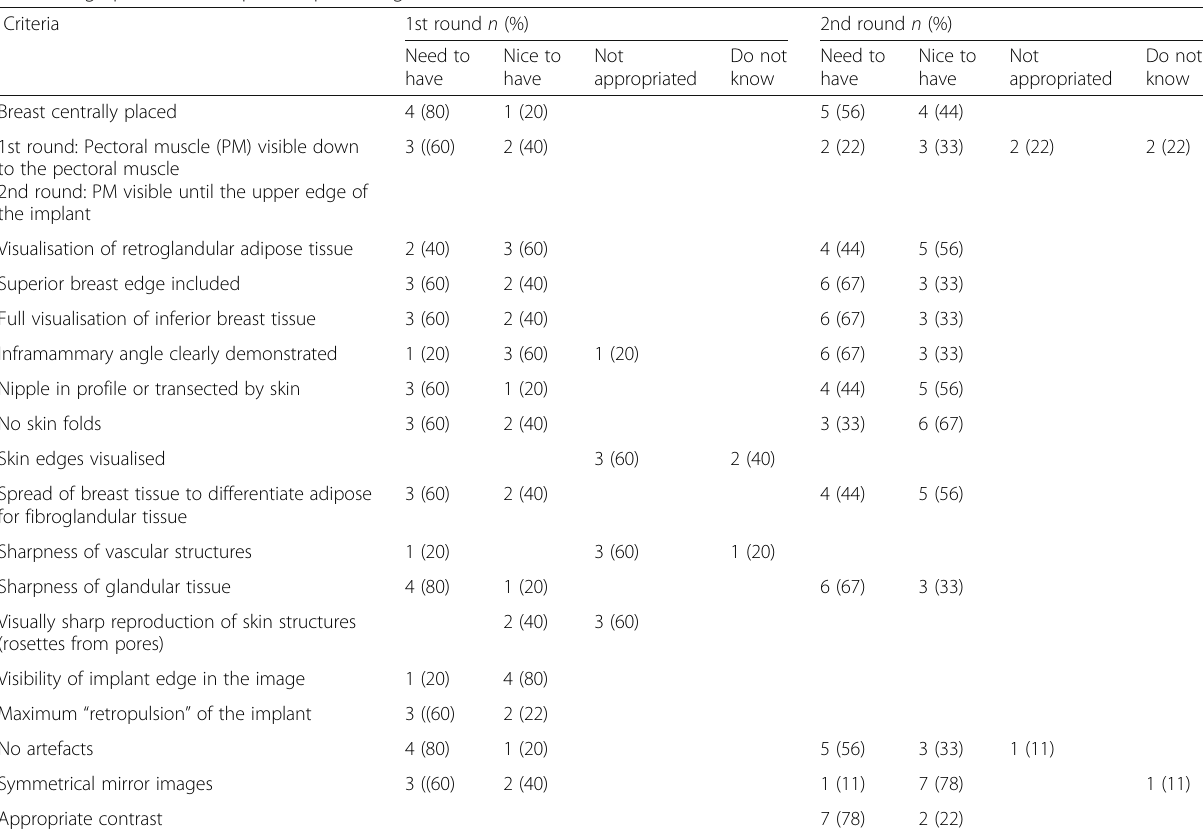
Table 6 Criteria scoring for mediolateral projection using Eklund manoeuvre combining the opinions of both groups (radiologists and radiographers) and respective percentage (%) Criteria